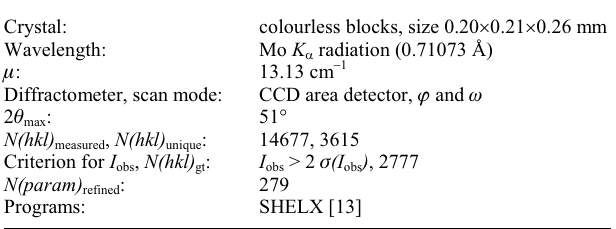
Table 1. Data collection and